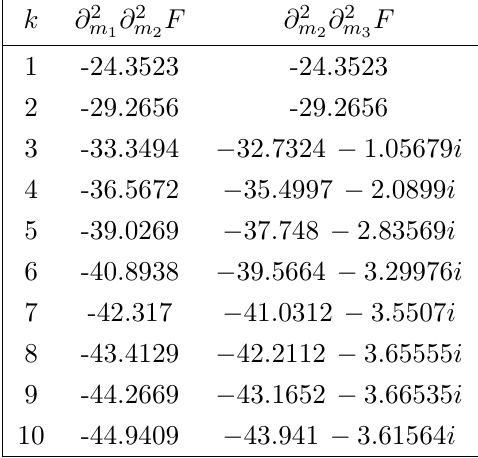
Table 2 . Explicit free energy derivatives for the U(1) k × U(2) − k ABJ theory for k = 1 , . . . 10 , where all derivatives as usual are evaluated at m I = 0 and b = 1